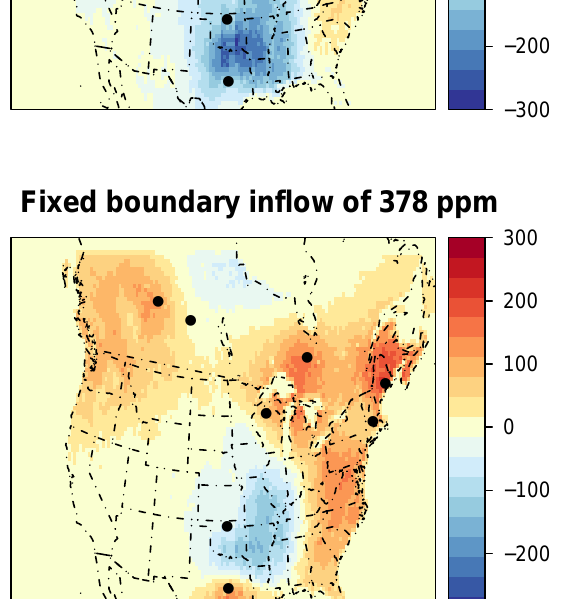
Fig. 7. Inversion estimates for three different inflow scenarios, one without modeled annual source/sink (PCTM w/SiB), one with mod- eled source/sink (CarbonTracker w/CASA), and a uniform fixed 378ppm inflow. Negative values denote land uptake of carbon. Summed annual NEE is − 0.65, − 0.48, and 0.38PgC/yr, respec- tively.